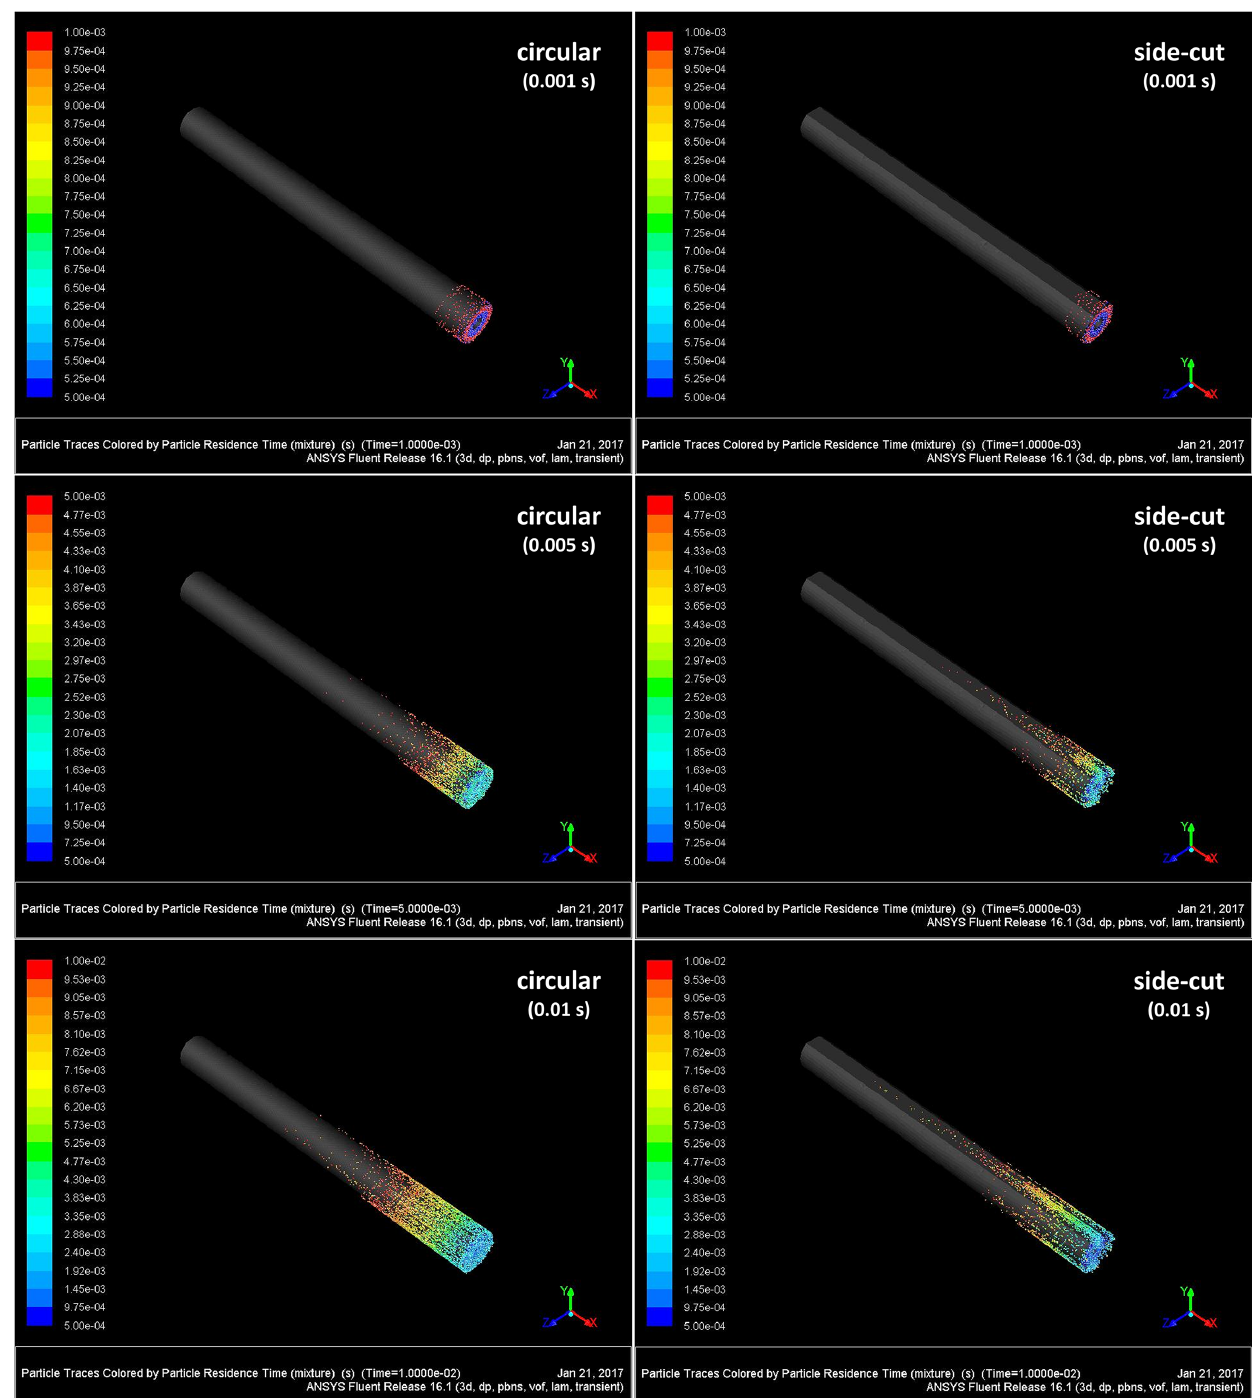
Figure 14. Debris distributions at increasing time steps.